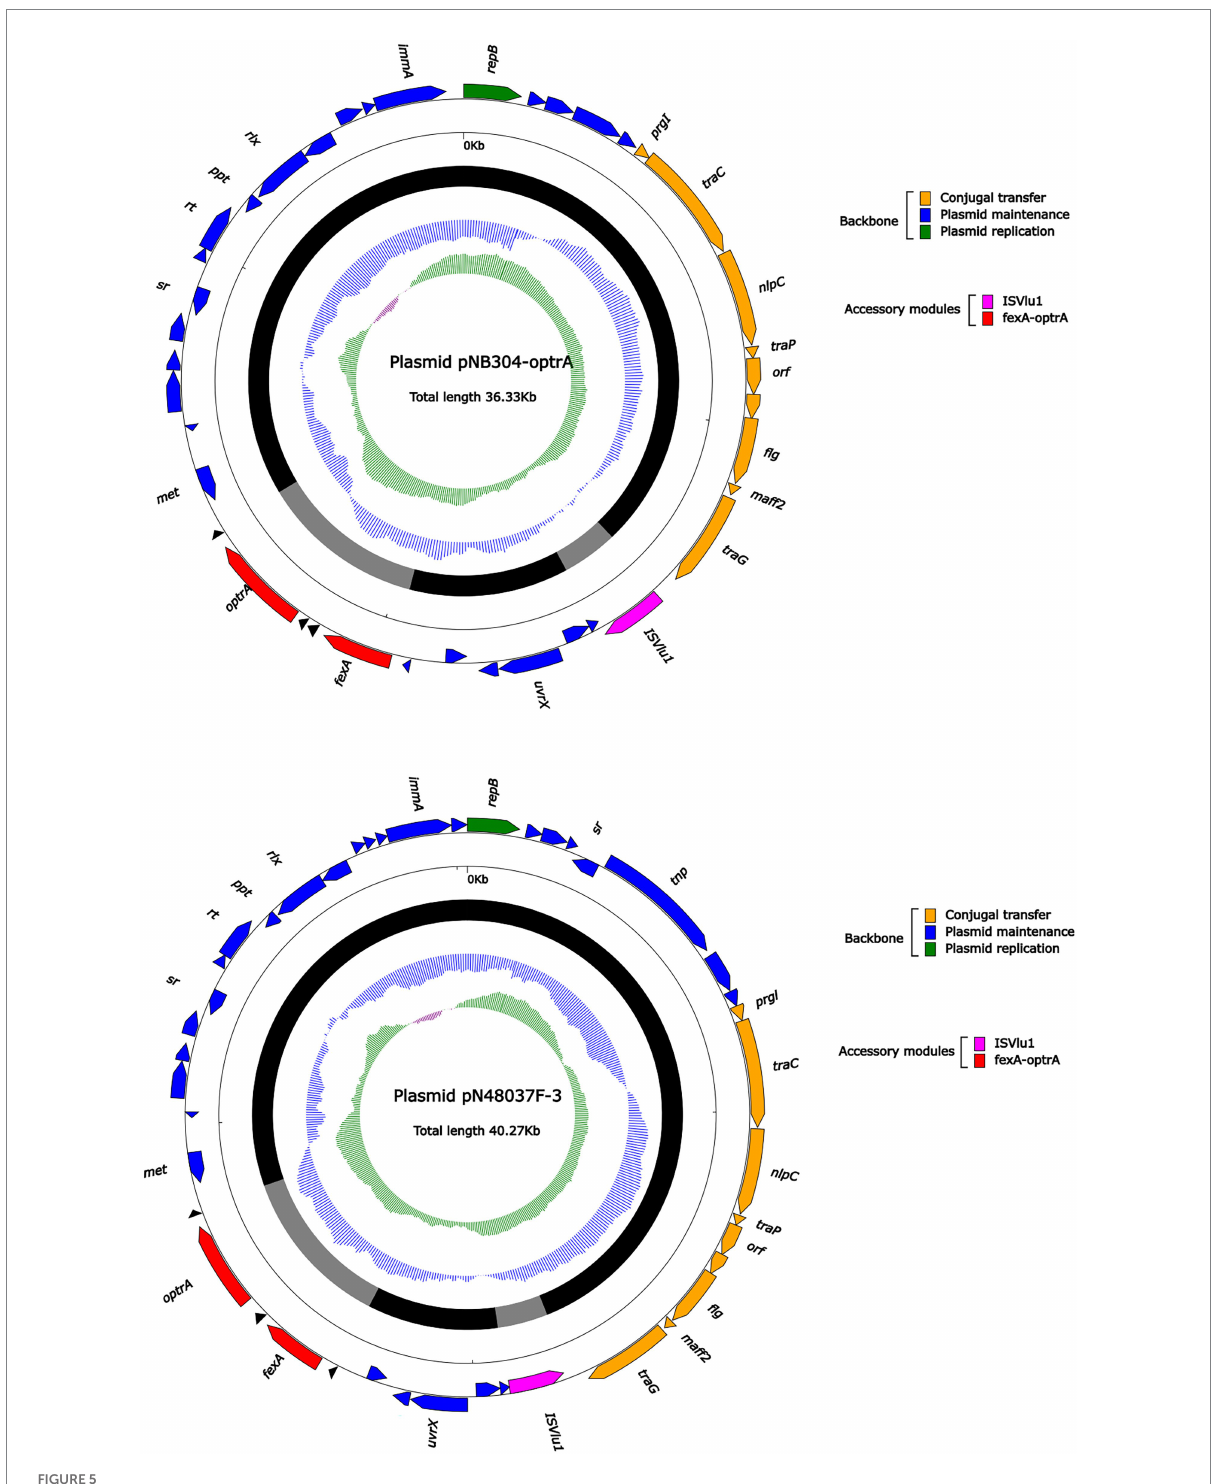
FIGURE 5 The complete sequence diagram of pNB304-optrA and N48037F-3.